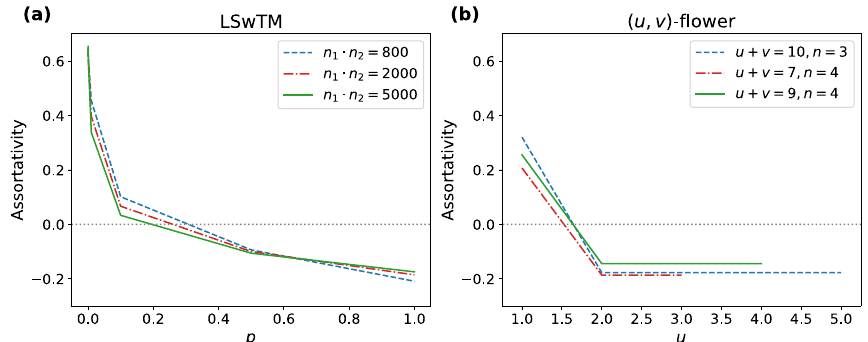
Fig. 13 Assortativity as a function of the parameter, which influences fractality for the a Lattice small‑world transition model, b ( u , v )‑flower. The grey dotted reference line shows Assortativity other models can be found in the supplementary material (Zakar‑Polyák et al.